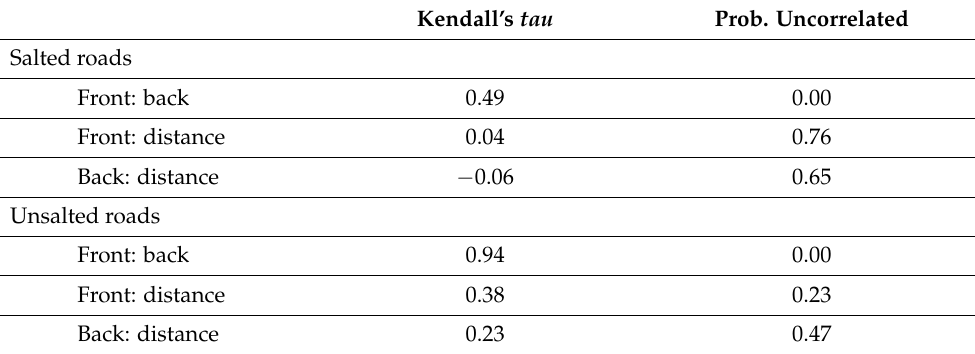
Table 1. Kendall’s tau rank correlation coefficient for damage on front and back of milestones and in relation to distance from roads. A value of tau closer to 1 indicates a higher correlation between the variables indicated in the first column, with a value of 0 indicating no correlation. The ‘Prob. uncorrelated’ column shows the two-tailed probabilities that the variables are uncorrelated, with a value closer to 1 indicating a higher probability of a lack of correlation, and a value closer to 0 indicating a lower probability of the variables being uncorrelated. Kendall’s tau Prob. Uncorrelated Salted roads Front: back 0.49 Front: